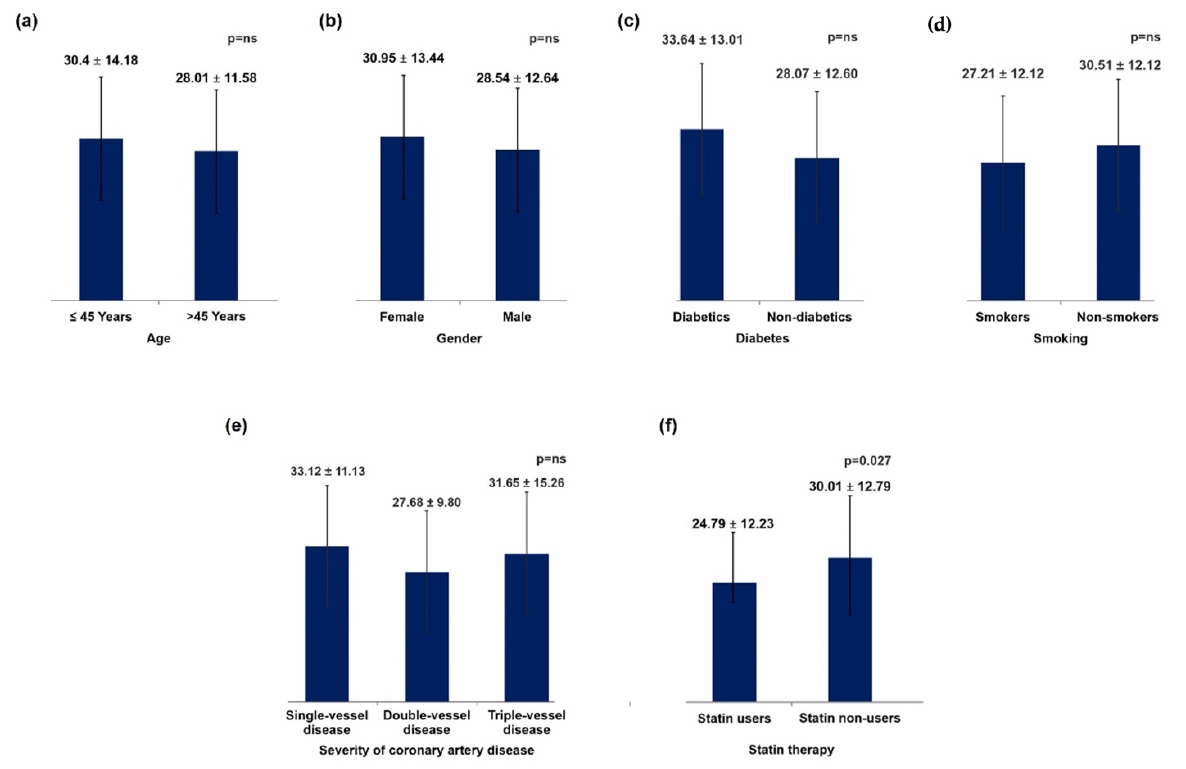
Figure 1. Sd-LDL levels according to demographic, clinical, angiographic, and therapeutic variables. ( a ). sd-LDL levels according to Age. ( b ). sd-LDL levels according to gender. ( c ). sd-LDL levels according to diabetes status. ( d ). sd-LDL levels according to smoking status. ( e ). sd-LDL levels